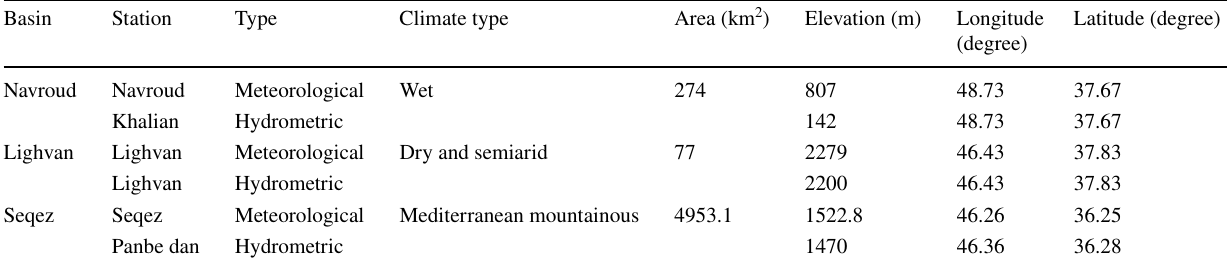
Table 1 Information of hydrometric and meteorological stations